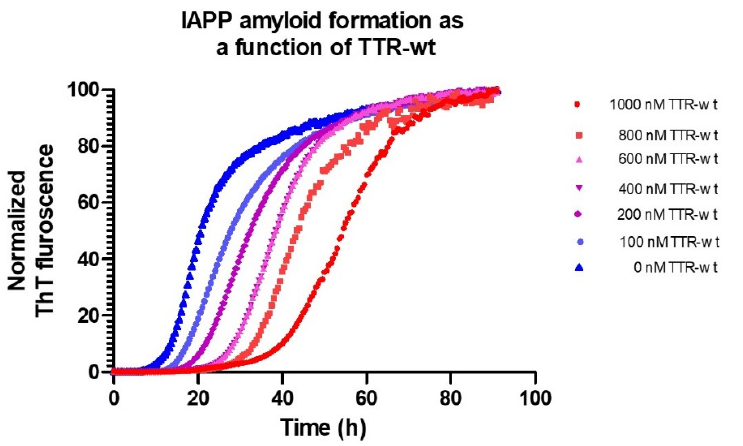
Figure 2. Amyloid formation of 5 µ M IAPP at 37 ◦ C, pH 7.5 in phosphate-buffered saline monitored by Thioflavin T as a function of various concentrations of TTR-wt.